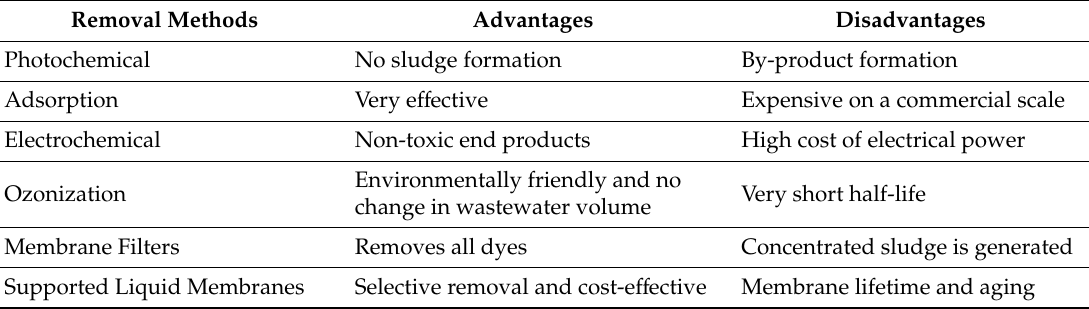
Table 1. Comparison of dye removal methods from